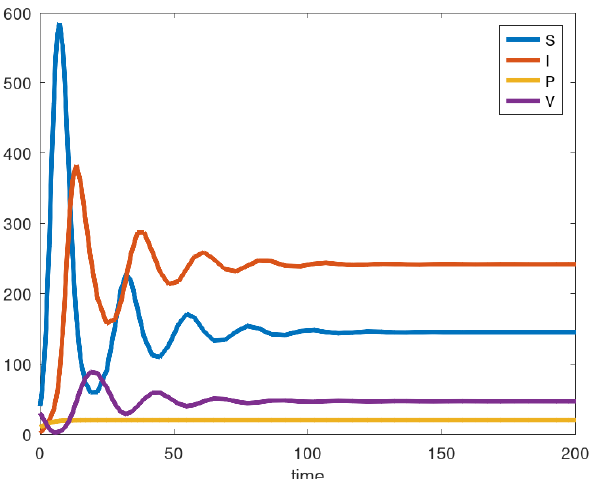
Figure 6. Coexistence (cid:98) E ∗ can be attained with the parameters in (23) and (28) and the initial condi- tions (22) and (27).